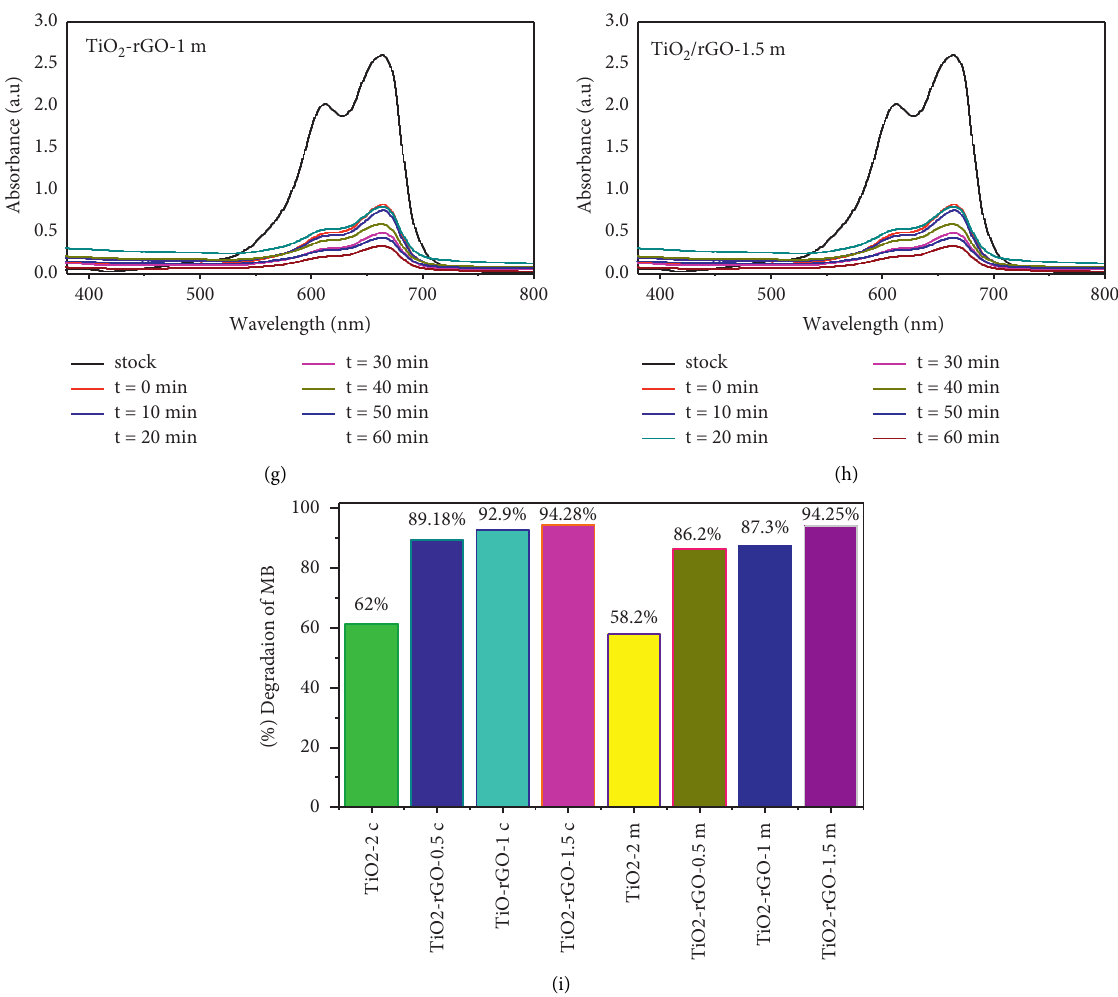
Figure 9: Visible light photocatalytic degradation of Citrus sinensis and Musa acuminata template synthesized TiO